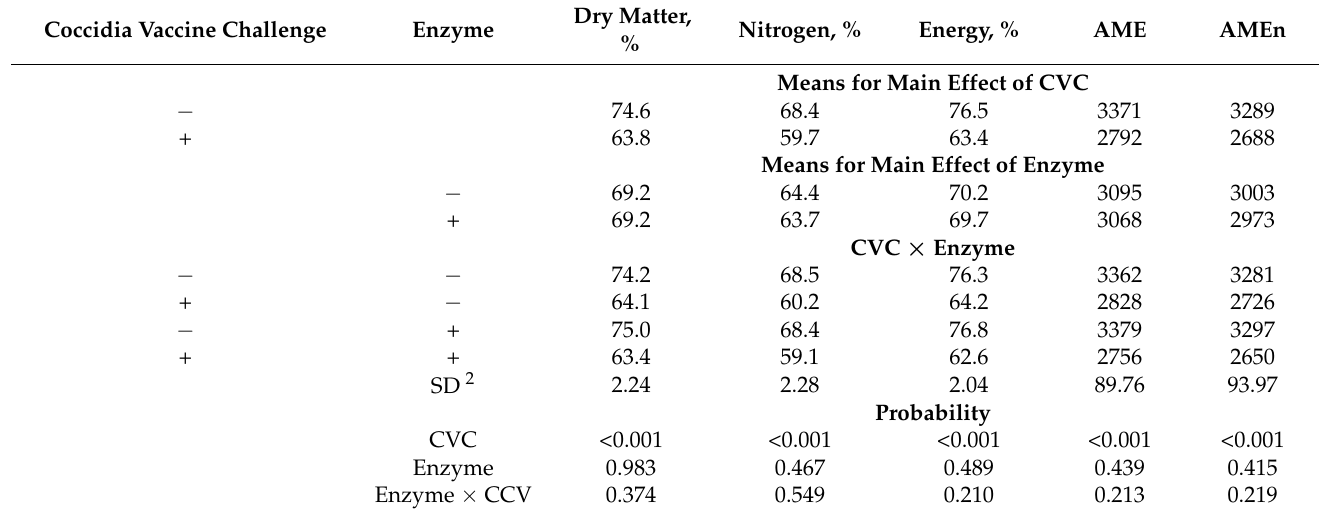
Table 4. Main and simple effects of coccidia vaccine challenge (CVC) and exogenous enzyme supplementation on nutrient and energy retention, apparent metabolizable energy (AME), and apparent metabolizable energy corrected for nitrogen (AMEn) in 21-day-old broiler chickens fed wheat-corn-soybean meal-based diets (7-day post-challenge) 1 . Coccidia Vaccine